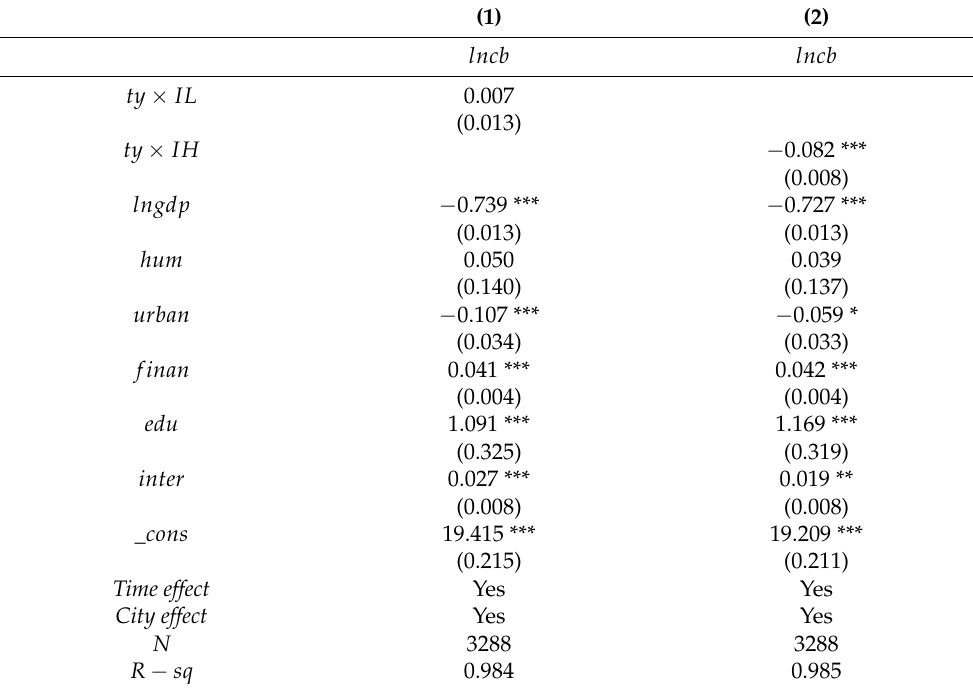
Table 4. Heterogeneity of information level.